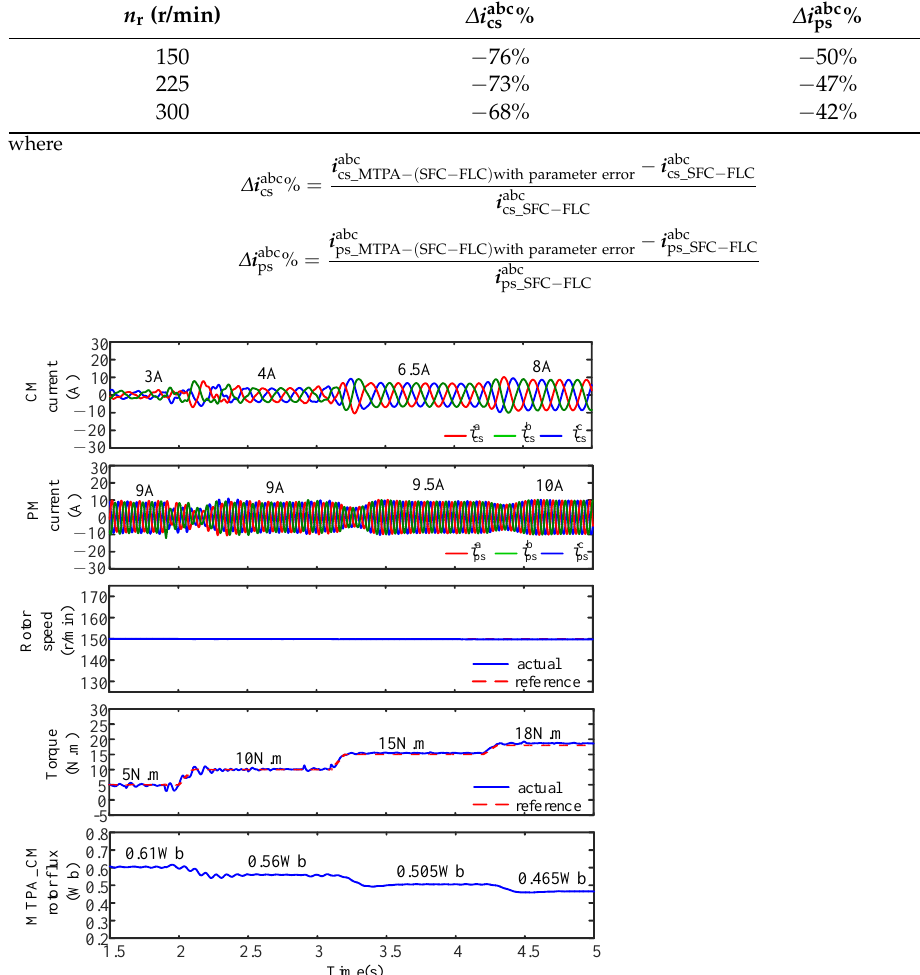
Figure 13. When the torque varies, the simulation experiment verifies the MTPA-(SFV-FLC)’s ro- bustness.